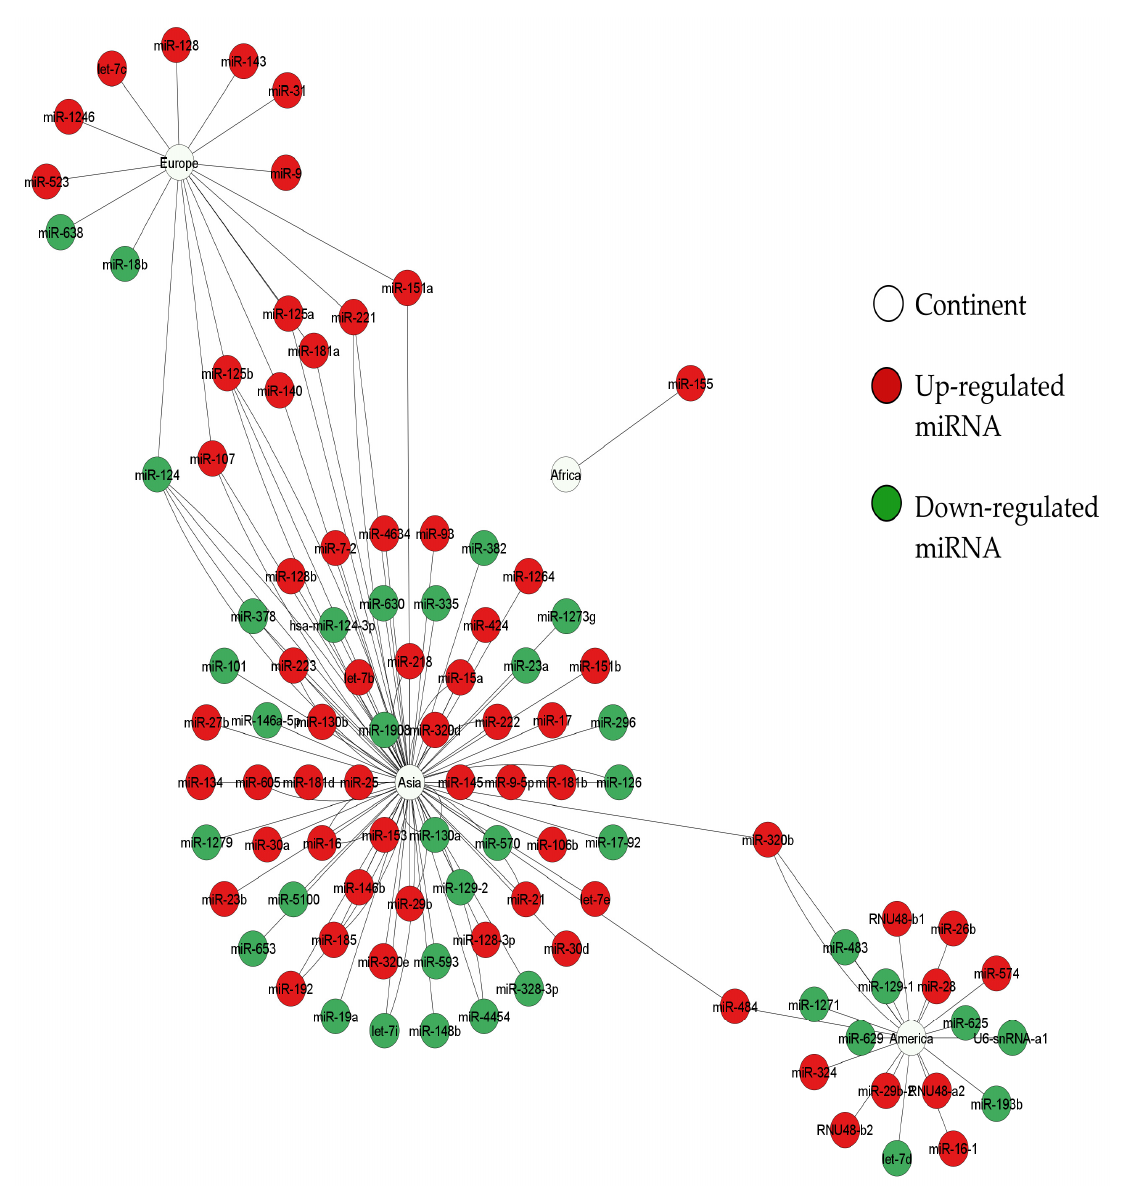
Figure 3. Structural network analysis of miRNAs that are differentially expressed in AIS from geographical samples. Data were extracted from 25 selected articles agreeing with our inclusion criteria (Table S1). Nodes correspond to miRNAs (targets according to their expression, those appear colored in red (upregulated) or green (downregulated)) and continents are shown as white nodes. Edges indicate different studies reporting the same miRNA from the same continent. (number of nodes: 103, number of edges: 133, network diameter: 6, network centralization: 0.713). The network was built using Cytoscape software (v.3.8.0). For a better image resolution, please review the Supplementary Materials (Figure